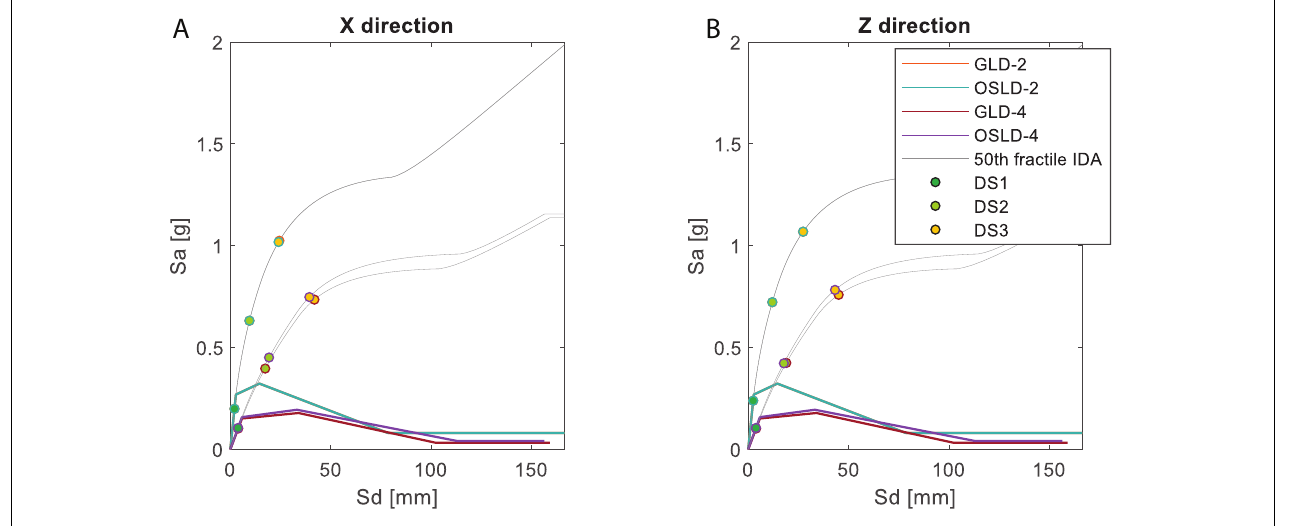
FIGURE 6 | SPO2IDA for the case study buildings: longitudinal X (A) and transverse Z (B)